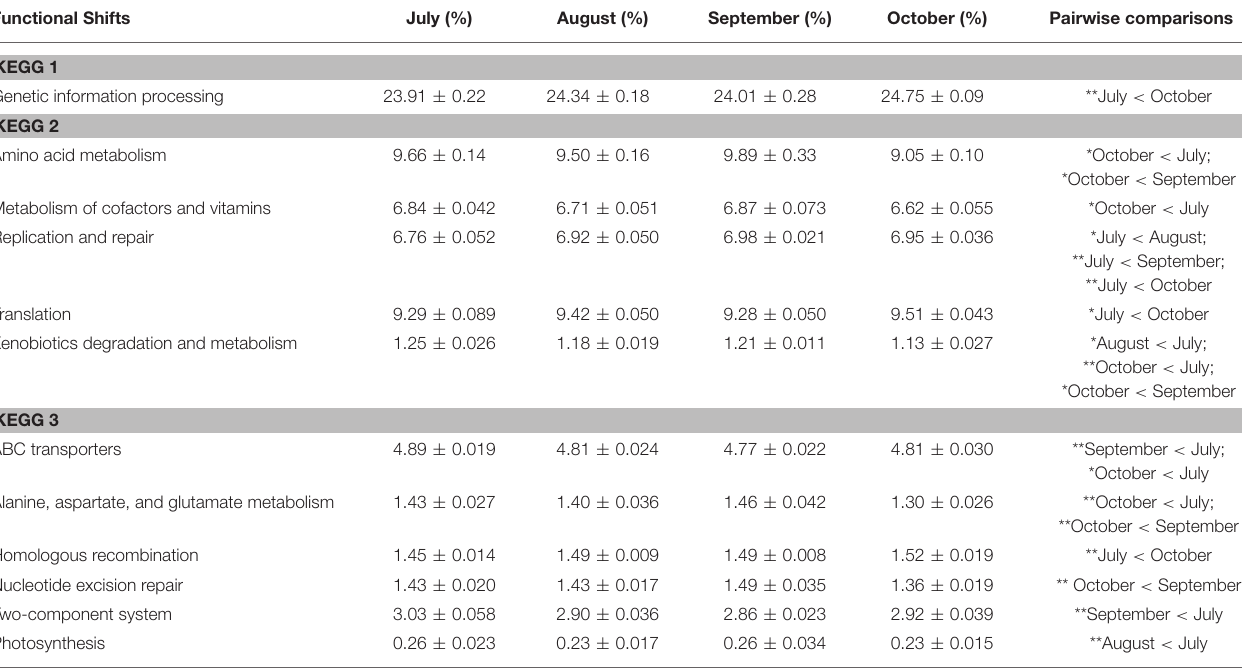
TABLE 3 | Statistically significant shifts in functional assignments across time in Siderastrea siderea metagenomes as measured by generalized linear mixed models with Tukey’s post-hoc test. Functional